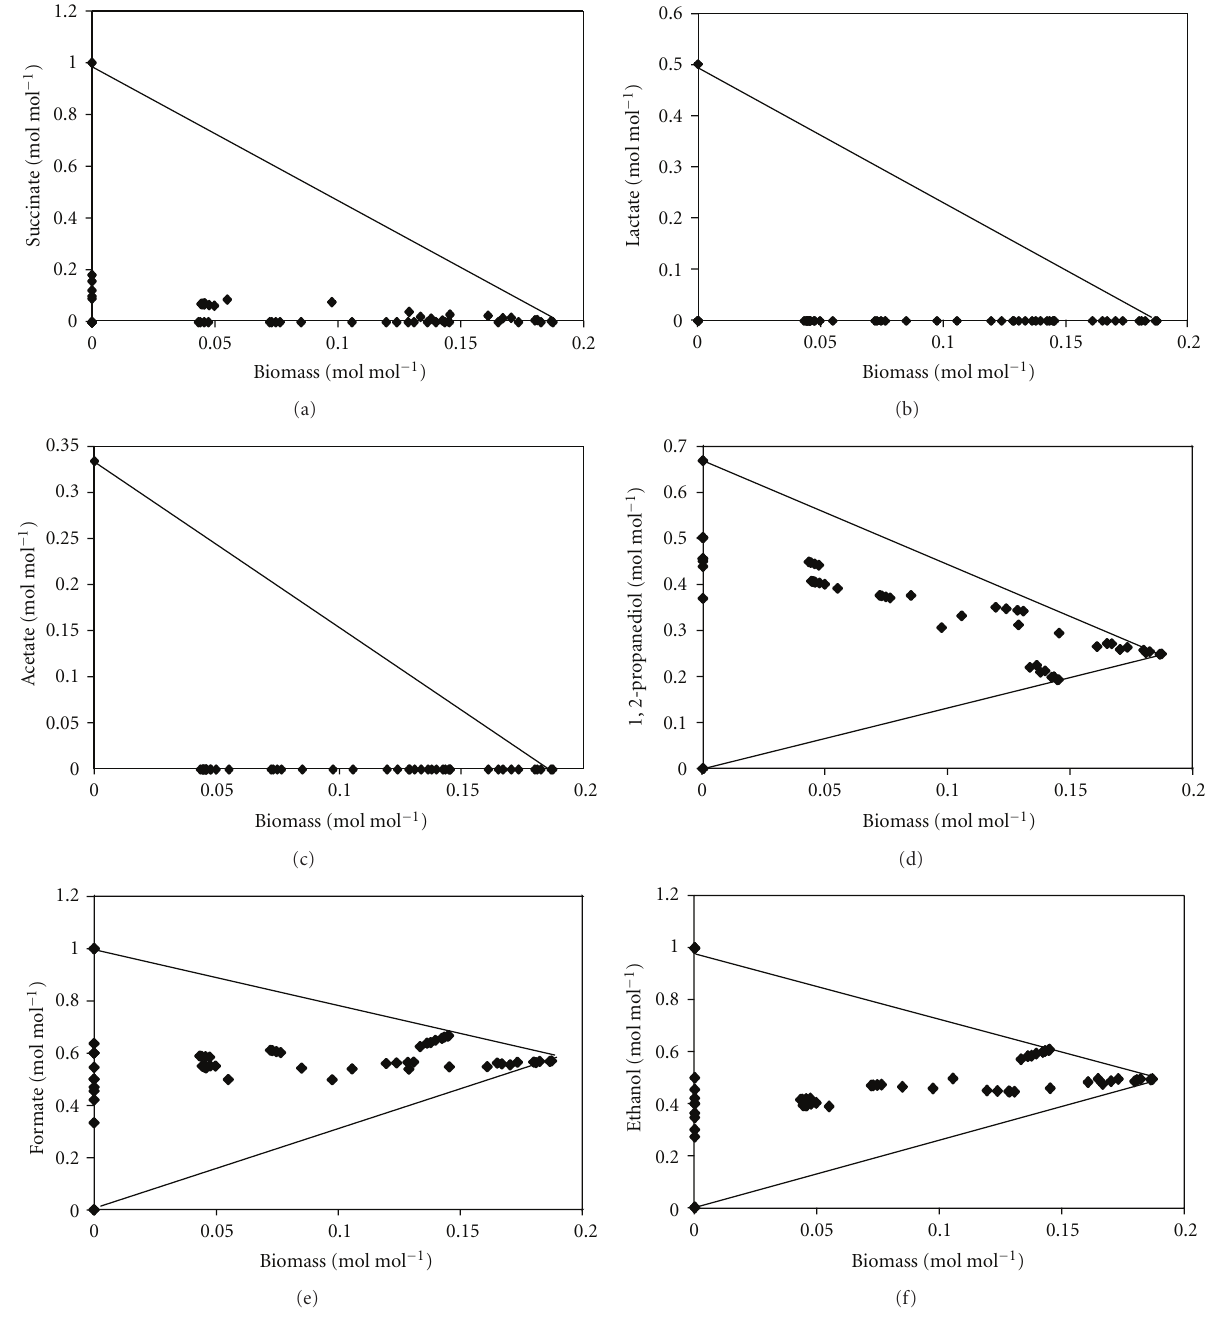
Figure 2: Relationship between the yields of biomass and byproducts for the obtained elementary modes of E. coli under anaerobic conditions. (a) Succinate, (b) Lactate, (c) Acetate, (d) 1,2-Propanediol, (e) Formate, and (f) Ethanol. The enclosed regions represent the possible solution space. The fluxes were normalized by glycerol uptake rate and expressed as mol/mol